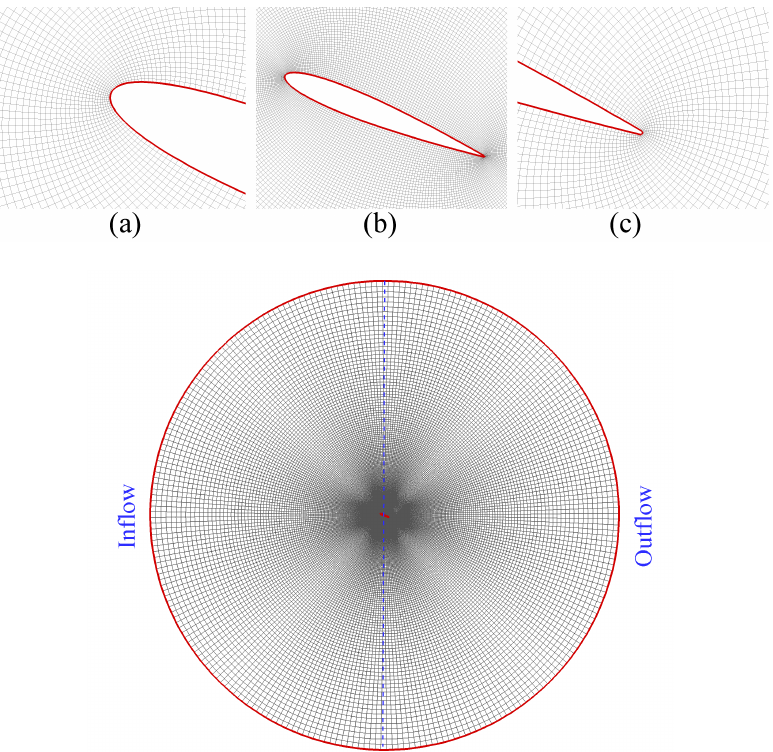
Figure 1. Two-dimensional layout of an ‘O’-type body-fitted grid over the NACA0012 airfoil. The grid-resolution close to the airfoil is shown in the upper row: ( a ) leading edge, ( b ) full airfoil, ( c ) circular trailing edge. Note that we generate the orthogonal grid between the airfoil and circular outer domain of radius 30c. We numerically solved the elliptic equations as used by Ryskin and Leal [54] to compute the grid